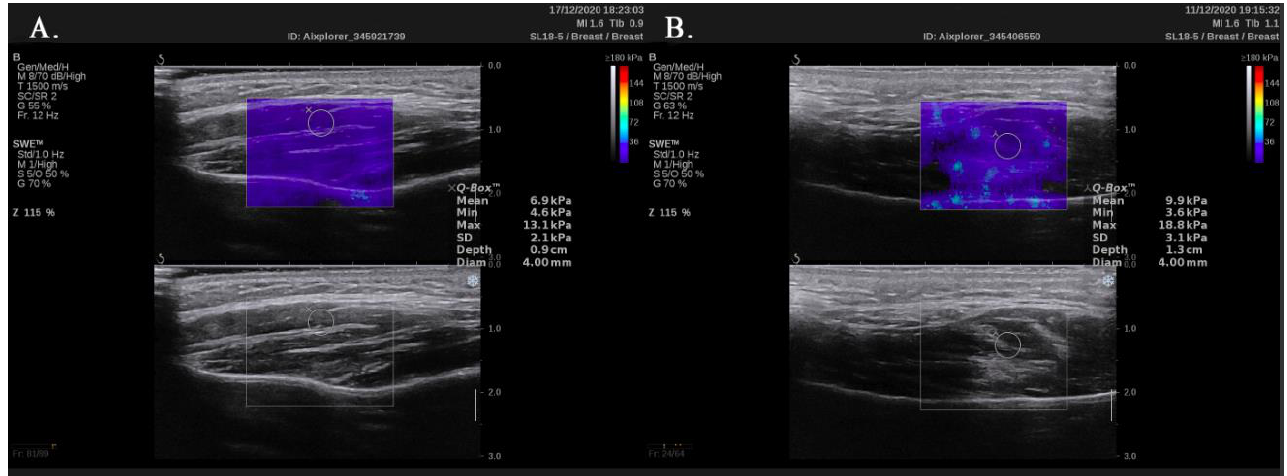
Figure 3. Shear wave elastography images of the masseter muscle of healthy volunteers: a 22-year-old woman ( A ) and 28-year-old man ( B.